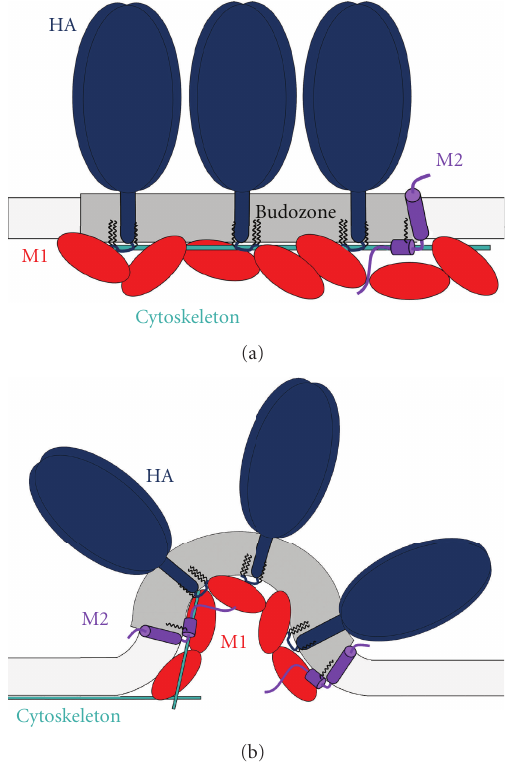
Figure 2: Schematic representation of influenza virus budding. (a) Formation of the budozone, a coalesced raft domain, in the plasma membrane. HA (blue) and NA (not shown) are targeted to rafts; M2 (purple) might be positioned at the edge of the budozone. M1 (red) binds to membranes and all the viral proteins including the viral RNPs (not shown) and clusters the viral components. The cytoskeleton (cyan) is involved in establishment of the budozone. (b) Formation of curvature for budding. Interactions involved: M1 acts as a sca ff old from beneath, the cytoskeleton provides outward pushing, the line tension at the domain boundary leads to bending, and the amphiphilic helix of M2 acts as a wedge. See text for